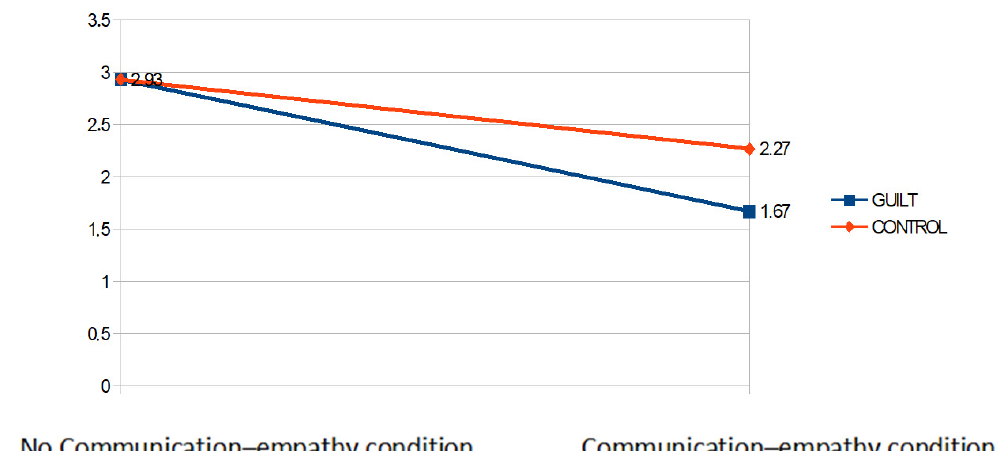
Figure 1. Mean of the tickets allocated to self in each experimental condition.